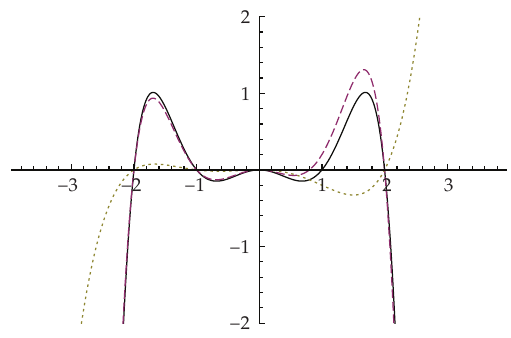
Figure 6: G (cid:3) x (cid:4) (cid:3) solid (cid:4) , G ε (cid:3) x (cid:4) (cid:3) dashed (cid:4) , and G (cid:3) x (cid:4) − G ε (cid:3) x (cid:4) (cid:3) dotted (cid:4)